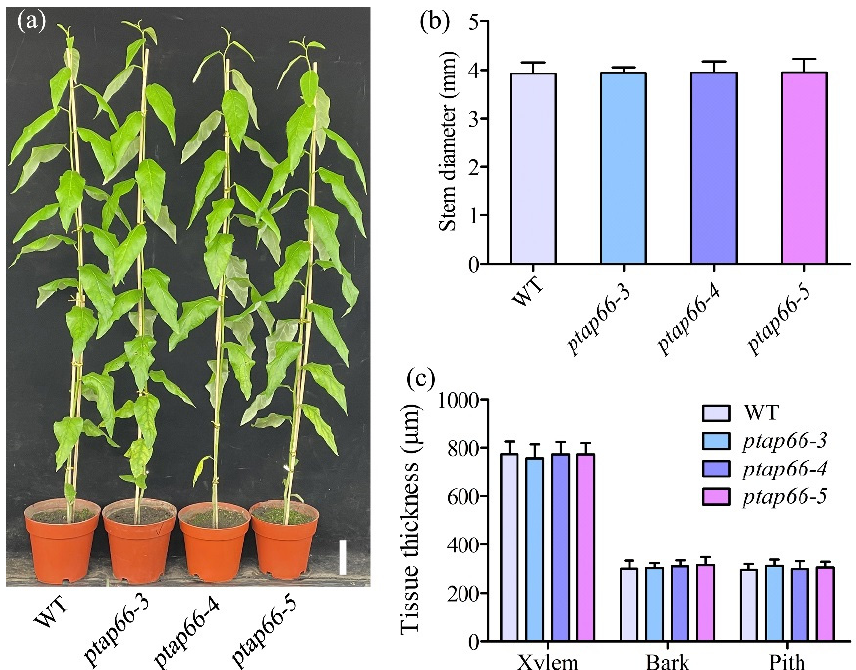
Figure 4. Characterisation of the ptap66 mutant lines. Growth phenotypes of 4-month-old ptap66 mutants and WT plants. Bar = 10 cm. These plants were measured for tree height ( a ), stem diameter ( b ), and stem tissue thickness ( c ). Error bars represent ± SD values of six biological replicates.